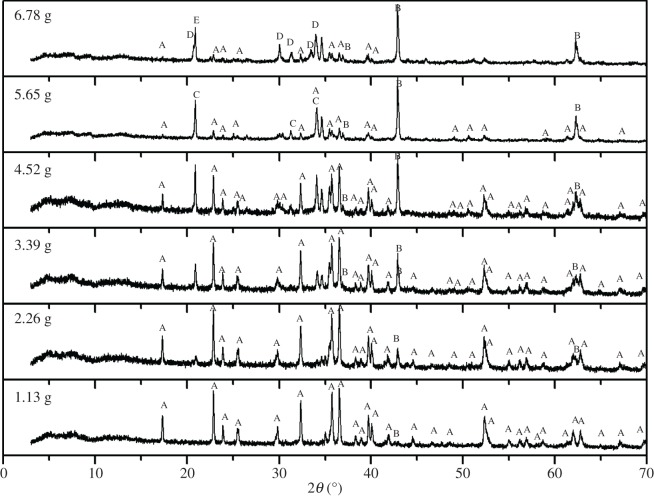
XRD patterns of sodium samples with different amounts of Na2CO3. (A) Mg2SiO4; (B) MgO; (C) Na2B4O7; (D) Na4Mg2Si3O10; (E) NaBO2.